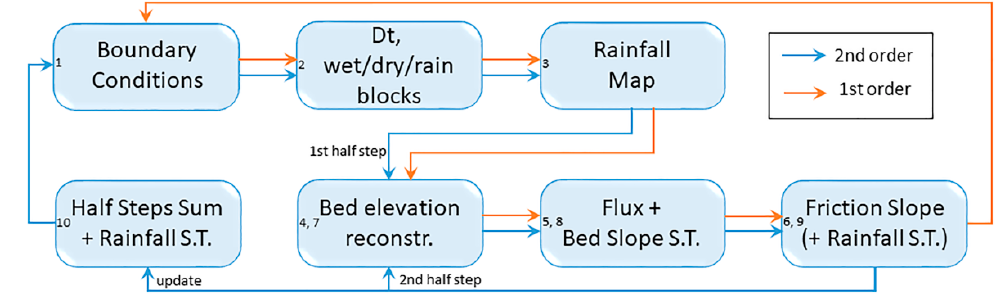
Figure 1. Iteration flux diagram. Each task is handled by a graphics processing unit (GPU) kernel.